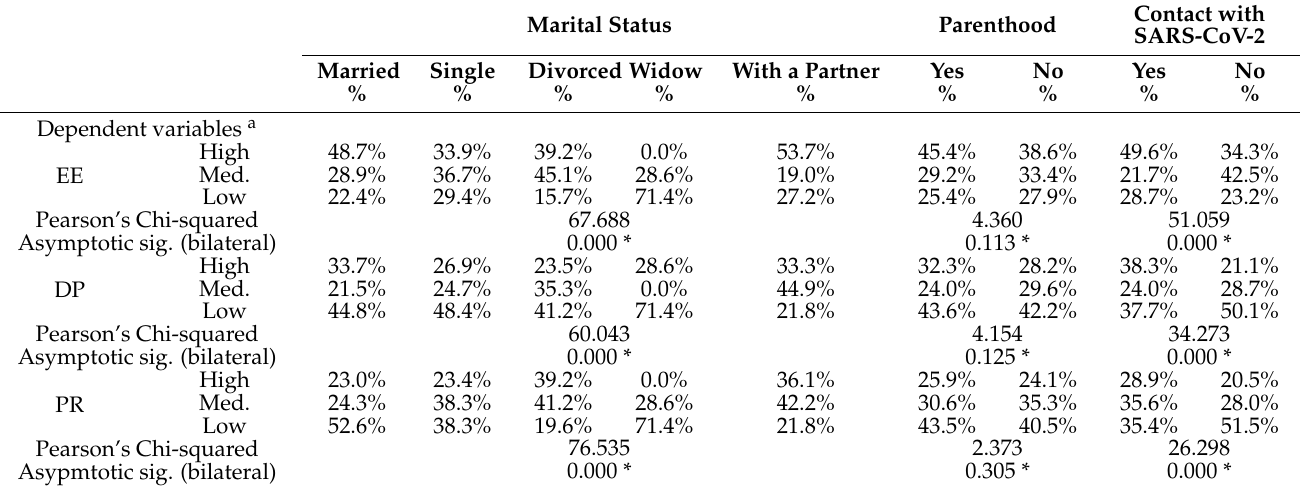
Contact with SARS-CoV-2